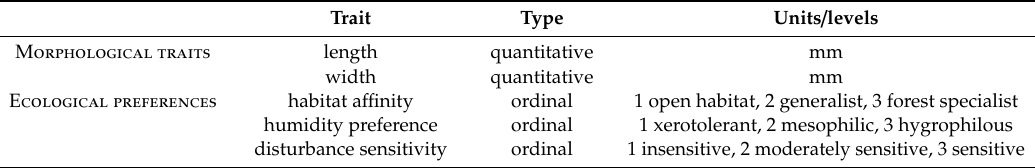
Table 1. Selected traits and ecological preferences of Diplopoda species. Trait Type Units / levels M orphological traits